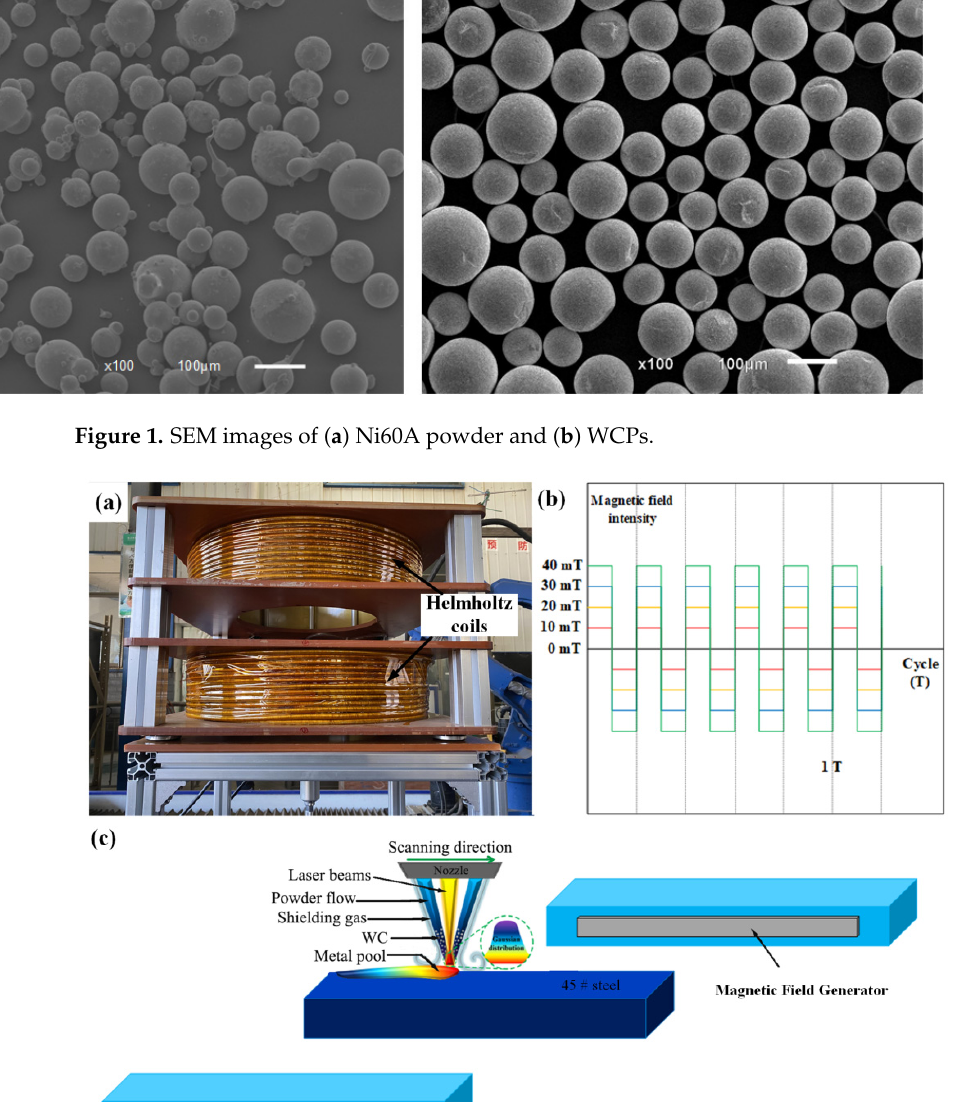
Figure 2. ( a ) Physical diagram of magnetic field generator; ( b ) schematic diagram of magnetic field waveform; ( c ) experimental schematic.